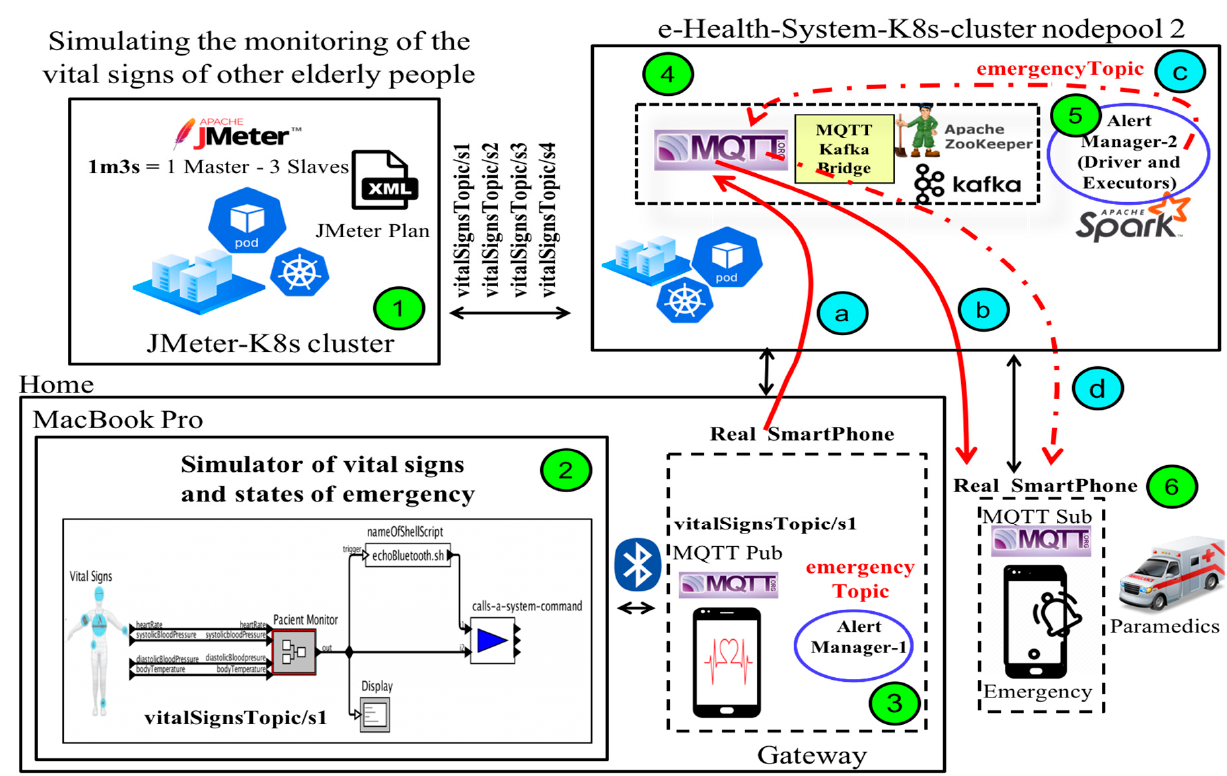
Figure 20. Test environment to measure the response time to generate an emergency alert. This environment consists of (1) a simulator of multiple patient vital sign messages, (2) a simulator of vital signs of a patient in critical condition, (3) a real smartphone with an app that collects data from the simulator of vital signs y contains the alert manager 1, (4) the messaging subsystem in the cloud computing environment consists of the EMQ cluster, MQTT–Kafka bridge, and the Kafka cluster, (5) a Spark application that was implemented as alert manager 2, and (6) a real smartphone belonging to medical personnel with an app that collects the emergency message from the EMQ cluster. Additionally, the figure shows the two analyzed routes through which emergency messages could be sent to paramedics: a–b and c–d.